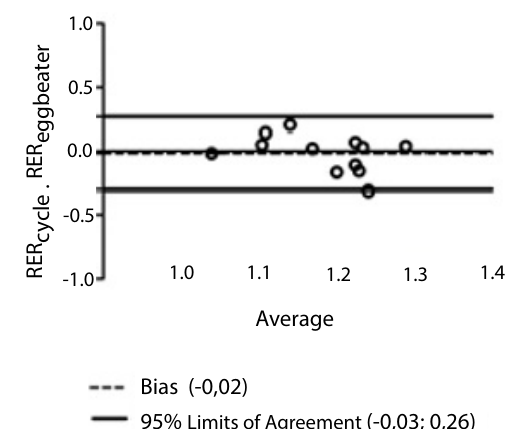
Figure 3. RER’s Bland–Altmann analyses.